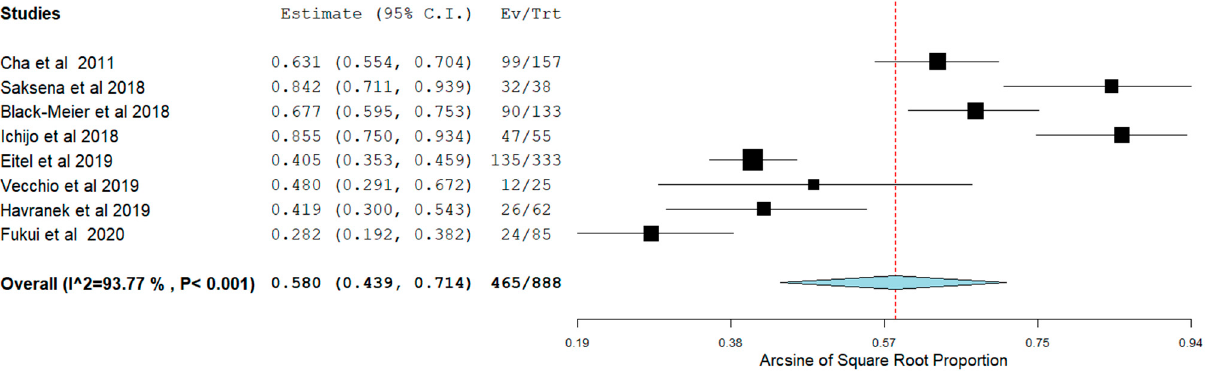
Figure 4. NSR post-ablation without AAD.